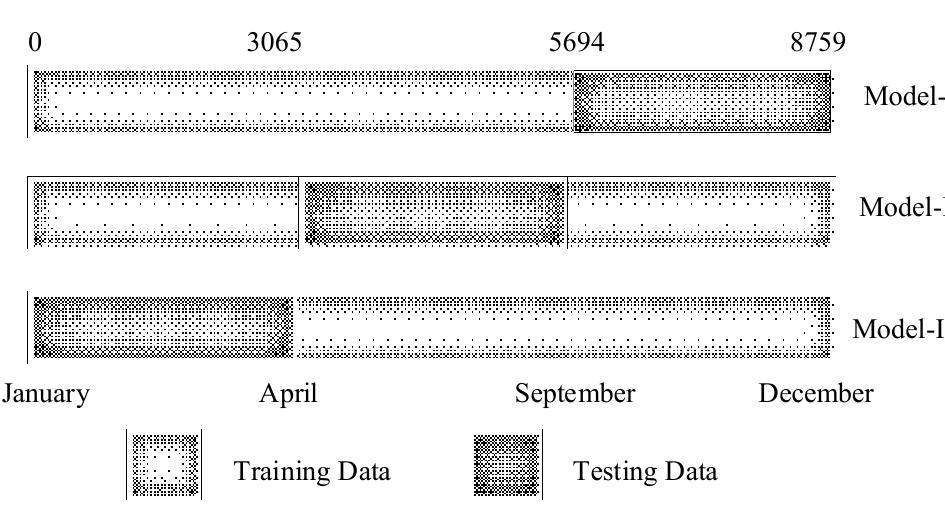
(40) Figure 7. Heatmap representation of the correlation between training and testing datasets.